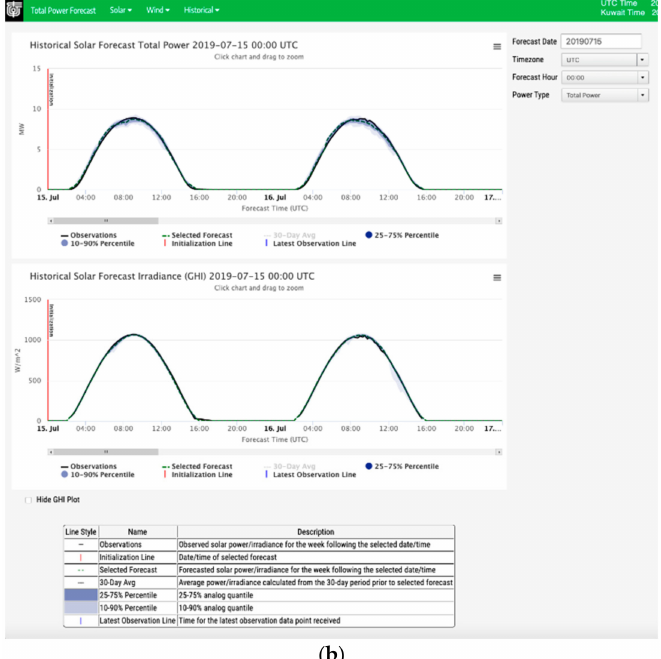
Figure 17. Example forecasts (dashed green lines) and observations (solid black lines) for ( a ) wind and ( b ) solar power for the KREPS forecast issued on 15 Jul 2019 at 00 UTC.